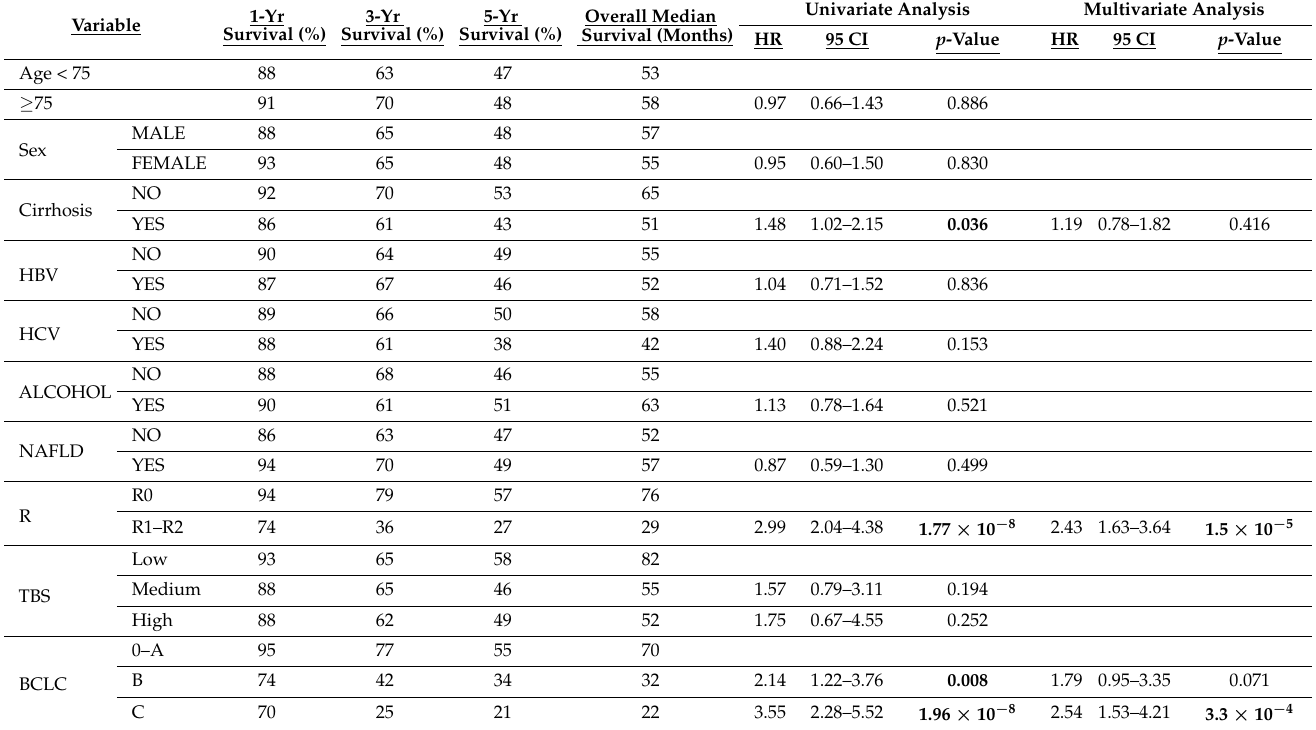
Table 4. Univariate and multivariate analysis of overall